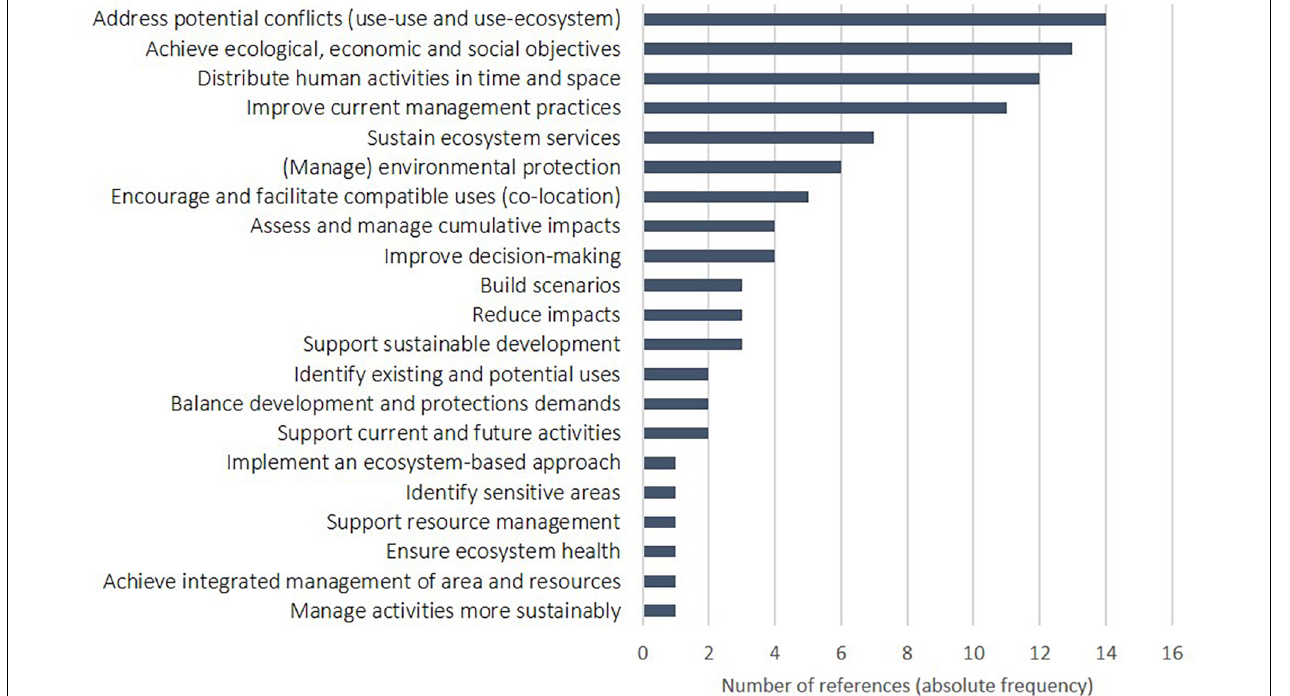
FIGURE 4 | Purposes of MSP found in the 30 “founding” documents and the number of times each purpose appears in such documents. Baseline data in Supplementary Material B